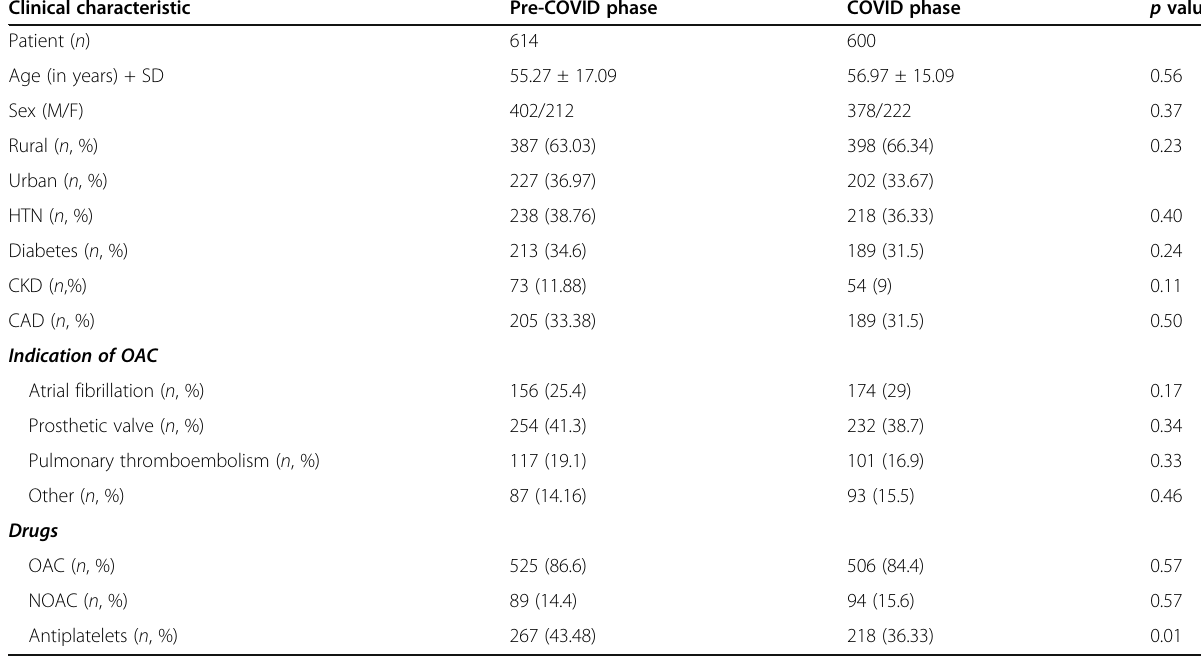
Table 1 Baseline characteristics of patients in COVID-19 phase and pre-COVID-19 phase Clinical characteristic Pre-COVID phase COVID